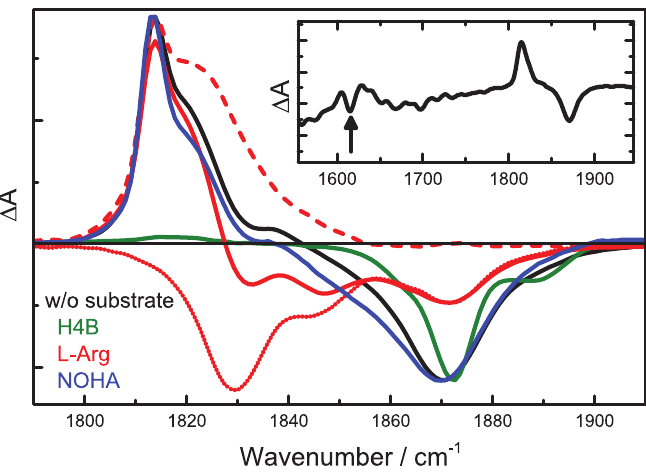
Figure 5. 4-K photolysis difference spectra of iNOS -NO. The stretching bands of heme-bound NO (NO after laser illumination at 300 mW) oxy are plotted with negative (positive) amplitude. A bands of the NOHA spectrum were scaled independently of photoproducts (factor 2.07) to match the A bands of the spectrum without substrate. Dotted line: 4-K photolysis difference spectrum of iNOS -NO/L-Arg, obtained upon oxy illumination at 0.3 mW. Dashed line: iNOS -NO/L-Arg photoproduct spectrum (obtained by calculating the difference between the two oxy iNOS -NO/L-Arg spectra). Inset: extended 4-K photolysis difference spectrum of iNOS oxy oxy